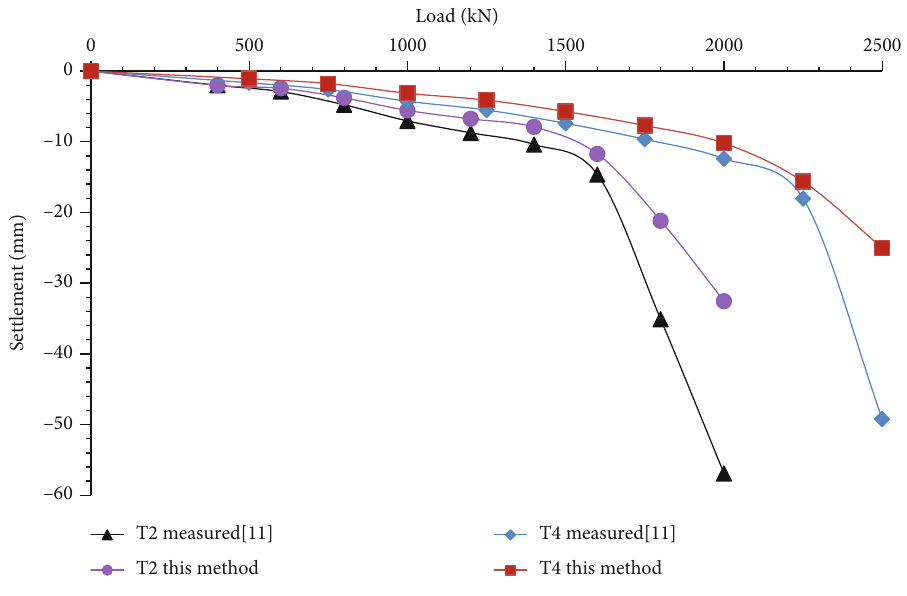
Figure 8: Load-settlement curves of T2 and